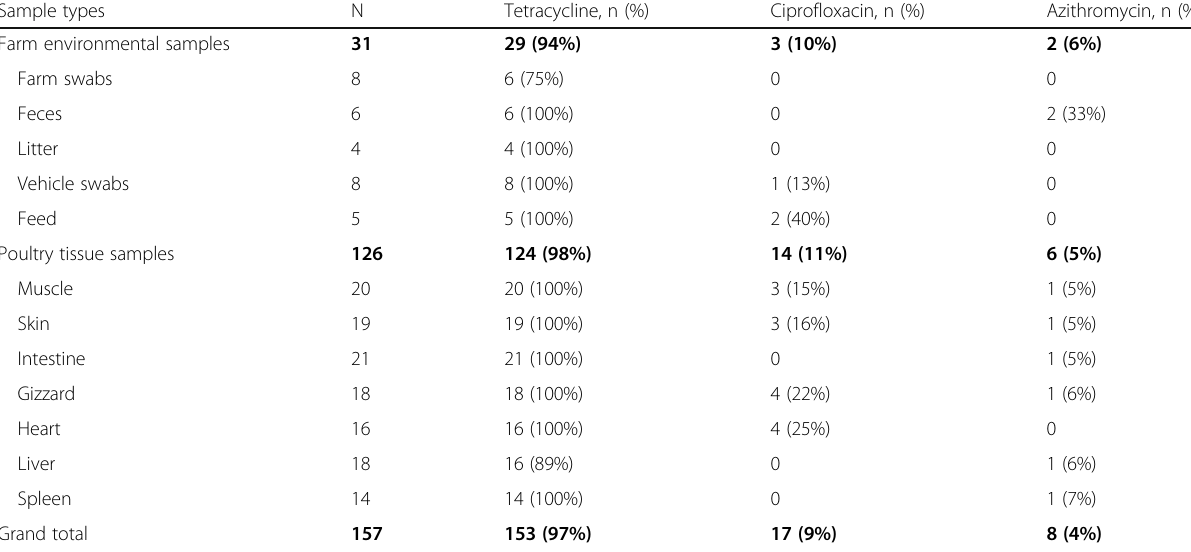
Table 2 Phenotypic antimicrobial resistance results of Salmonella enterica isolates by sample types Sample